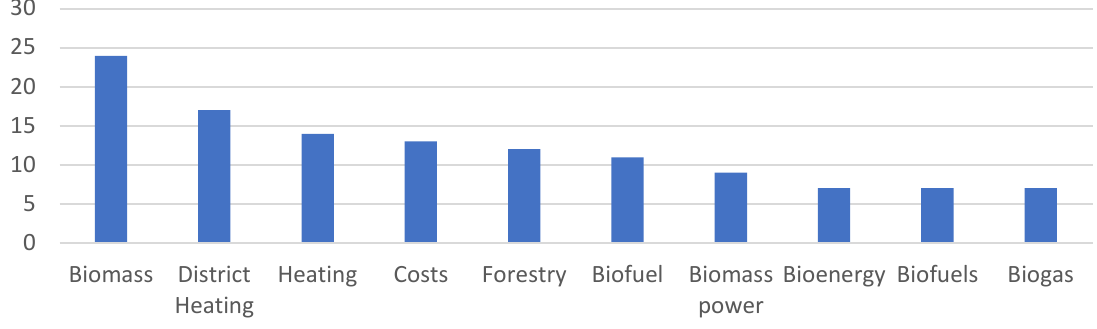
Figure 5. Fuel—most frequent keywords (horizontal axis) and the number of articles (vertical axis).